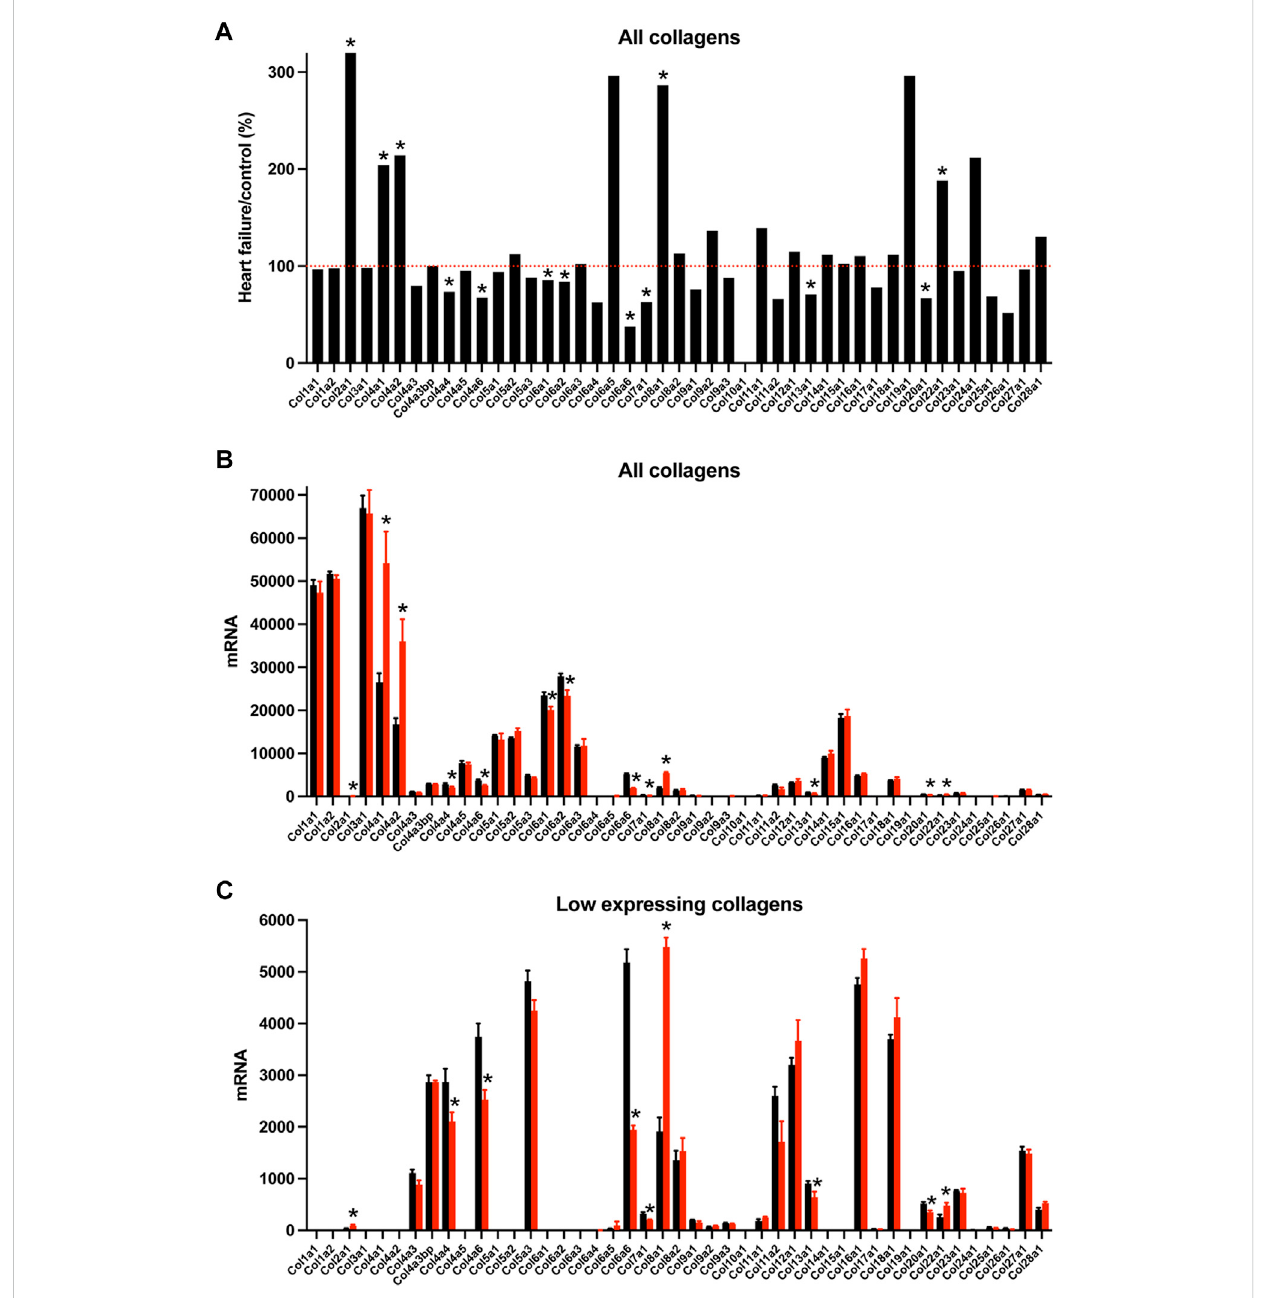
FIGURE 6 Transcriptomic remodelling of the extracellular matrix of the AV node in HF. (A) , expression of all collagen transcripts in HF mice as a percentage of that in control mice. Red dotted line corresponds to 100%. (B and C) , expression of highly expressed collagen transcripts (B) and more poorly expressed collagen transcripts (C) in control (black bars) and HF (red bars) mice. Only means + SEM shown (individual data points not shown for clarity). * p <